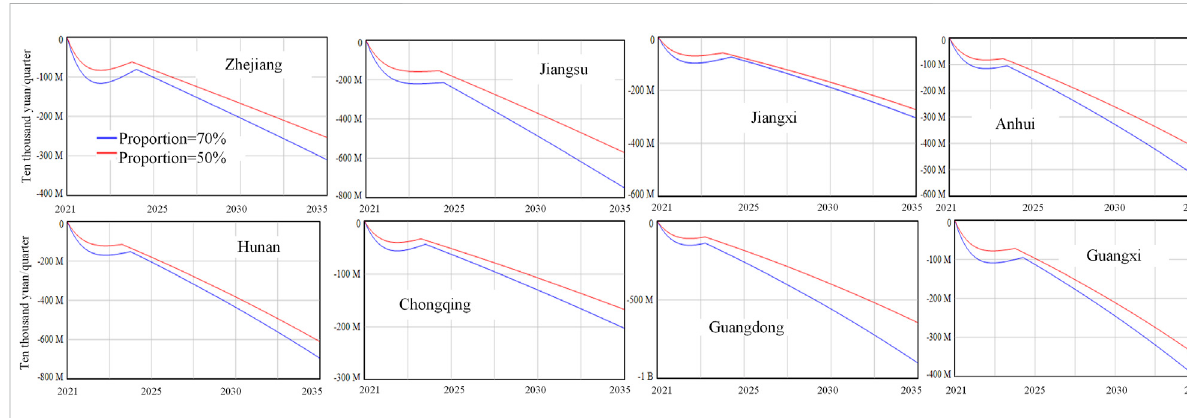
FIGURE 12 Annual net pro fi t of non-central heating provinces and cities after adjusting heating proportions.